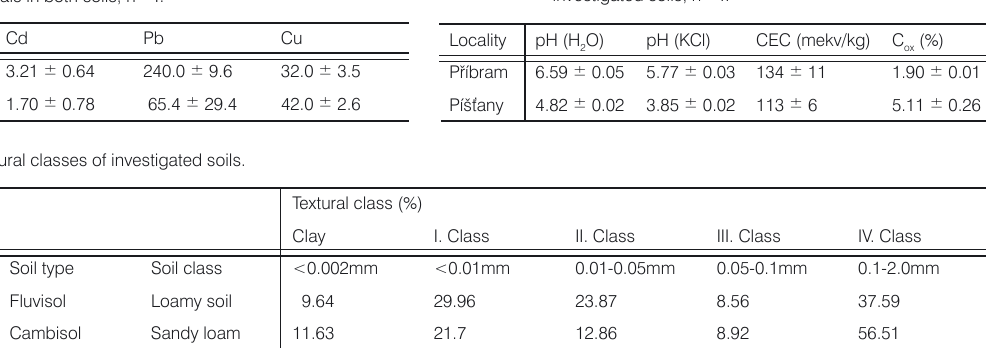
Table 3. Soil properties (pH, CEC (Cation Exchange Capacity) and C (percentage content of oxidizable carbon)) of ox investigated soils,